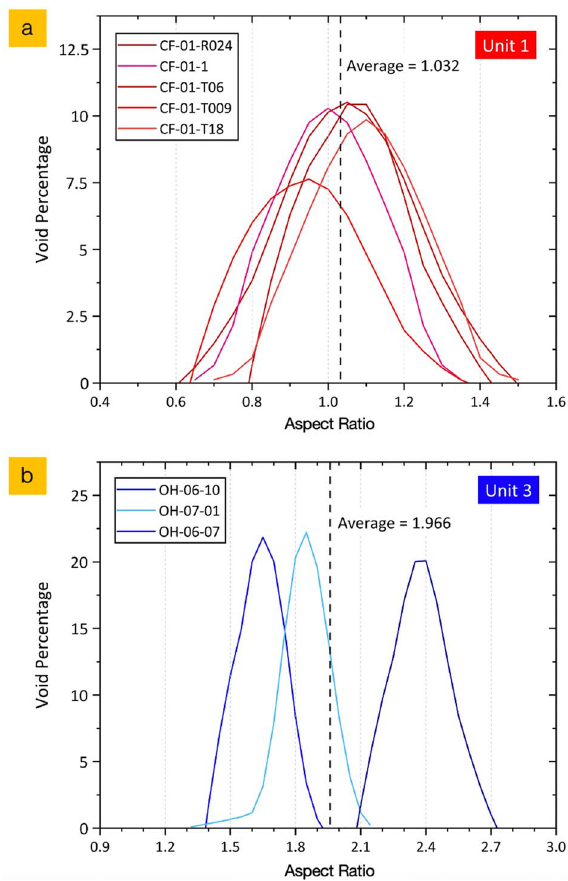
Figure 5. Void aspect ratio analysis of XRT sections (obtained at sequential 20 µm height increments/slice thicknesses) through; ( a ) Unit 1 particulates and ( b ) Unit 3